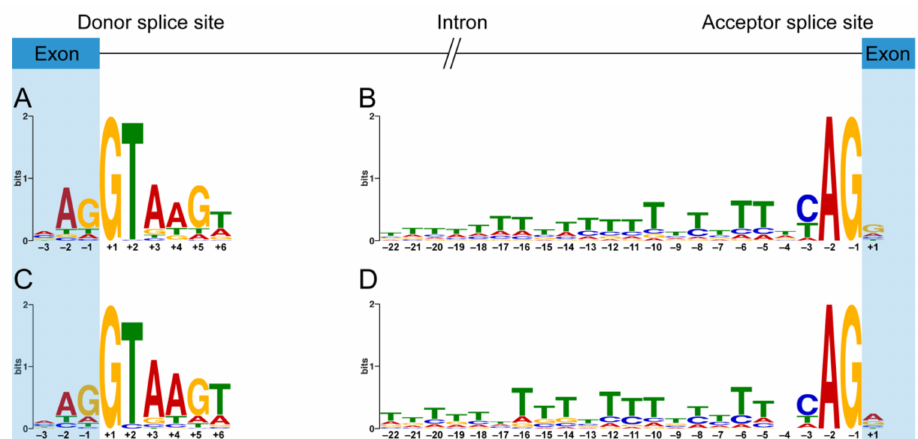
Figure 4. Position weight matrix-based splice site consensus motifs of dystrophin pseudoexons and canonical exons. Sequence logos for donor ( A ) and acceptor ( B ) splice site consensus motifs of dystrophin canonical exons and the consensus sequences are MAG | GTAAGW and TTTWTTTTTTTTTTTTTTWYAG | G, respectively. Sequence logos for donor ( C ) and acceptor ( D ) splice site consensus motifs of dystrophin pseudoexons and the consensus sequences are MAG | GTAAGT and TTTTTHTTTYTTTTYYTTNCAG | R, respectively. The height of each letter reflects the relative frequency of that nucleotide in the respective position. “ | ” indicates the exon–intron boundary in the consensus sequence. H stands for any nucleotide except G, Y for C or T, N for any nucleotide, R for A or G, M for A or C, and W for A or